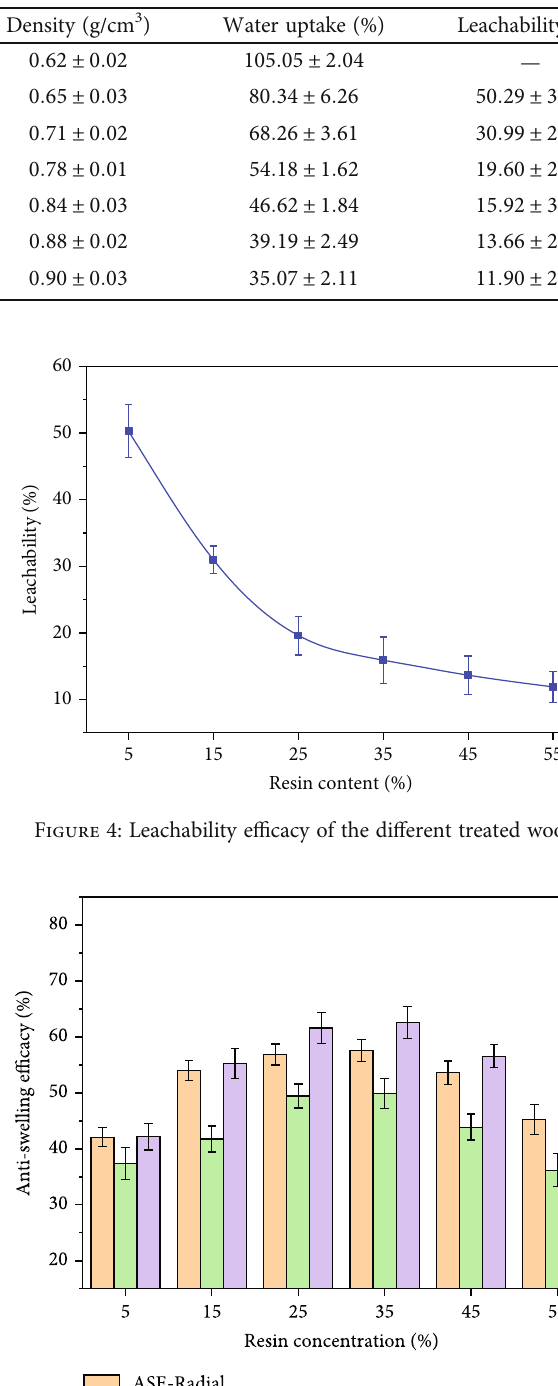
Table 3: Physical properties of the control and treated wood.